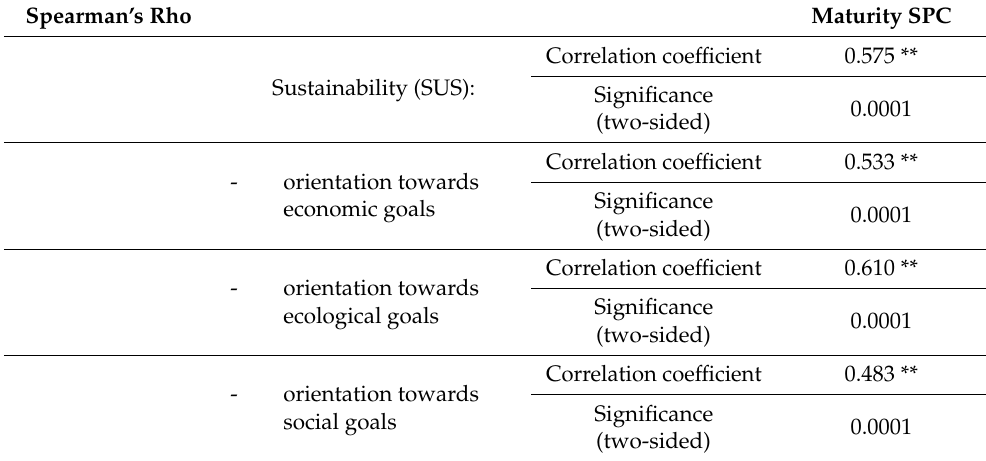
Table 7. Correlation between SUS and SPC ( n =